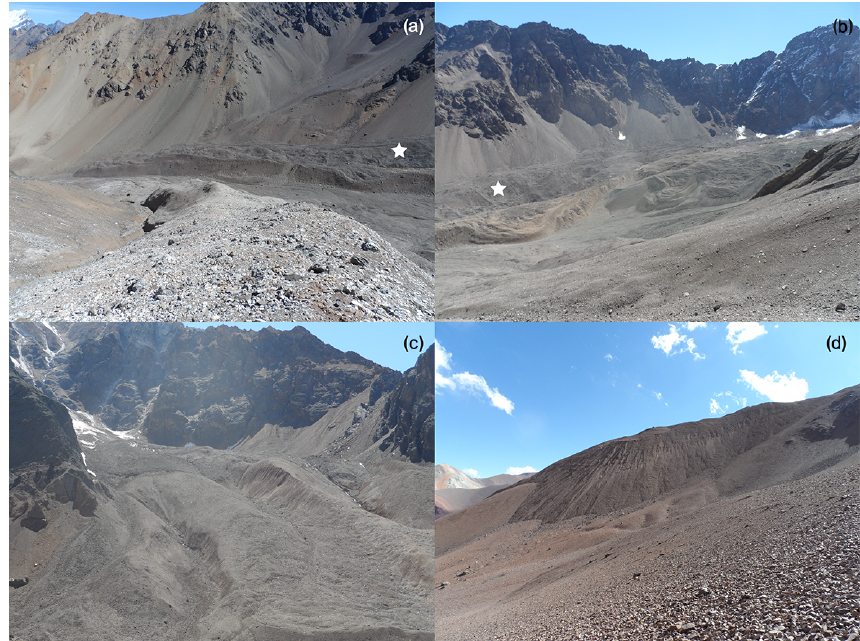
Figure 4. Photos of the lower (a) and upper part (b) of Navarro, seen from Presenteseracae; Presenteseracae seen from Navarro (c) ; and the terminal part of Las Tetas (d) seen from its northeastern surrounding area. The white stars on photos (a) and (b) indicate the main location of the central depression and related thermokarst morphology on Navarro (see Fig.